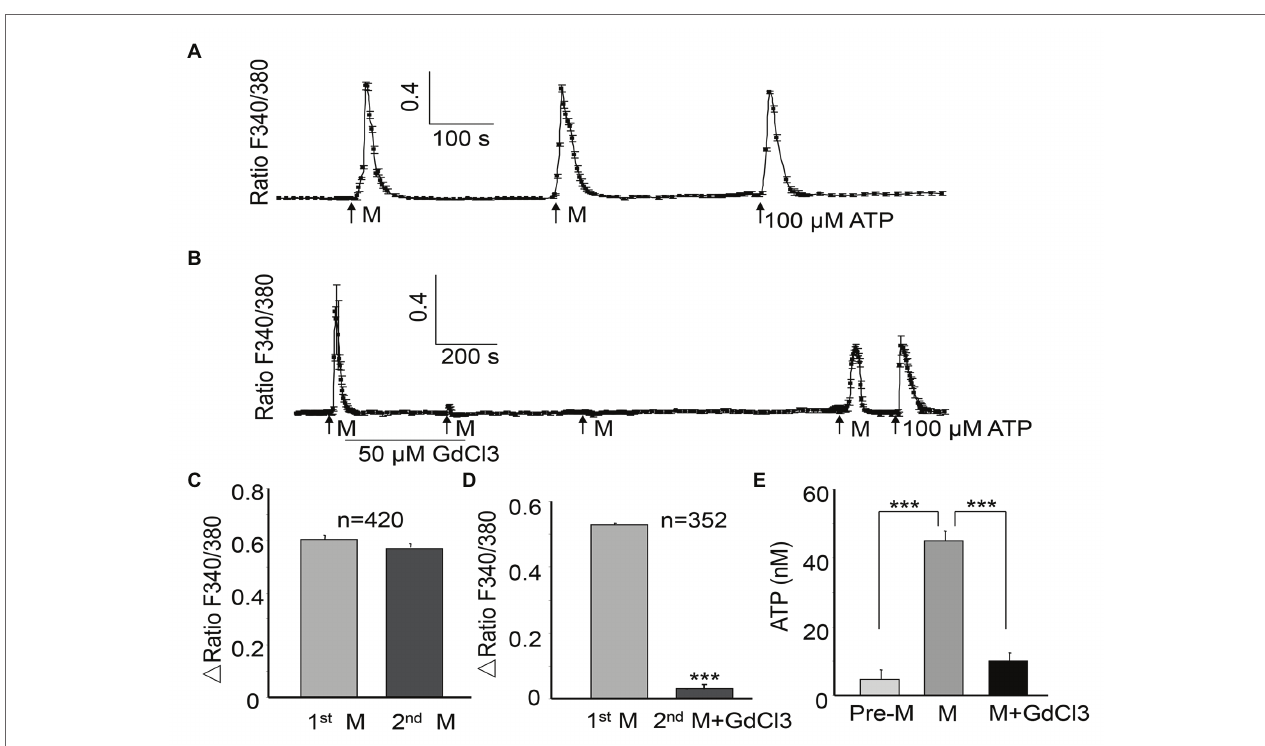
FIGURE 2 | Air-liquid interface evokes the repeatable [Ca 2+ ] i increases and ATP release in urothelial cells, which can be blocked by GdCl3. A [Ca 2+ ] i increase is expressed as the ratio of fluorescence at 340 and 380 nm (F340/F380). (A) One typical trace showing the ALI (M)-evoked reversible [Ca 2+ ] i increase. The trace was obtained by averaging the responses of six cells from the same coverslip. The application of ATP (100 μ M) at the end of the experiment evoked significant Ca 2+ increase, indicating good viability of the cells. (B) One typical trace (averaging five cell responses) showing that GdCl3 (50 μ M) almost abolished the ALI-induced [Ca 2+ ] i increase, and the blocking effect was long lasting. (C) Summary data from 420 cells showing that the amplitude of the second ALI-induced [Ca 2+ ] i increase was not significantly different from the first. The amplitude of the [Ca 2+ ] i increase was calculated by subtraction of the peak from baseline and expressed as Δ ratio of F340/F380. (D) Summary data from 352 cells showing that the amplitude of the [Ca 2+ ] i increase was significantly attenuated in the presence of GdCl3 ( p < 0.001). (E) Among five coverslips, ALI evoked a significant increase in ATP concentration in the perfusate, compared with without ALI (Pre-M). Pretreatment with GdCl3 blocked the ALI-evoked ATP increase ( p < 0.001). ATP concentration was measured as described in the Material and Methods